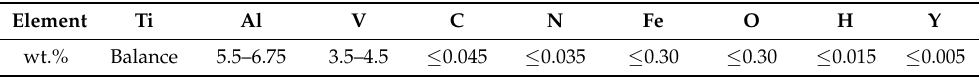
Figure 5. Microstructure of used Ti-6Al-4V feedstock as-sintered. Table 1. Chemical composition of used Ti-6Al-4V feedstock as-sintered [25], reproduced with permis- sion from Element22